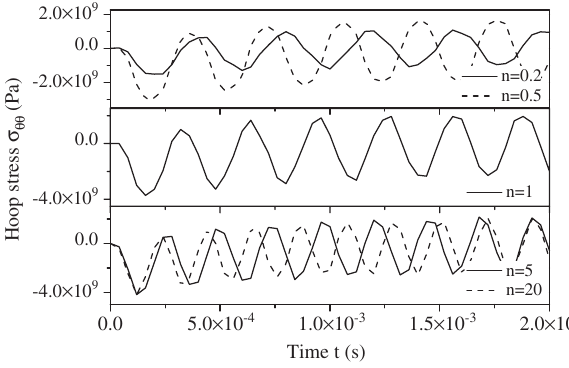
Figure 13 Response histories of hoop stress in the FGM hollow cylinder with different n , where r = 0.375 m.